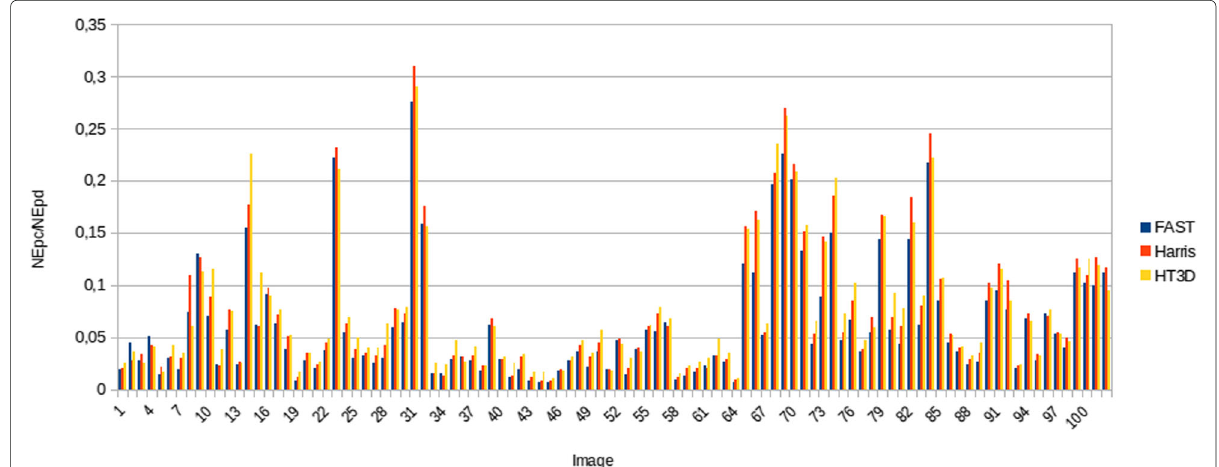
Fig. 17 Ratio between NEp c (number of correct matchings between ground truth and detected points) and NEp d (total number of detected points) for the whole dataset considering d Ep = 2 (distance between ground truth and detected points). No significant variations of this ratio can be observed among the three methods when reducing d Ep . This indicates a similar accuracy of the compared